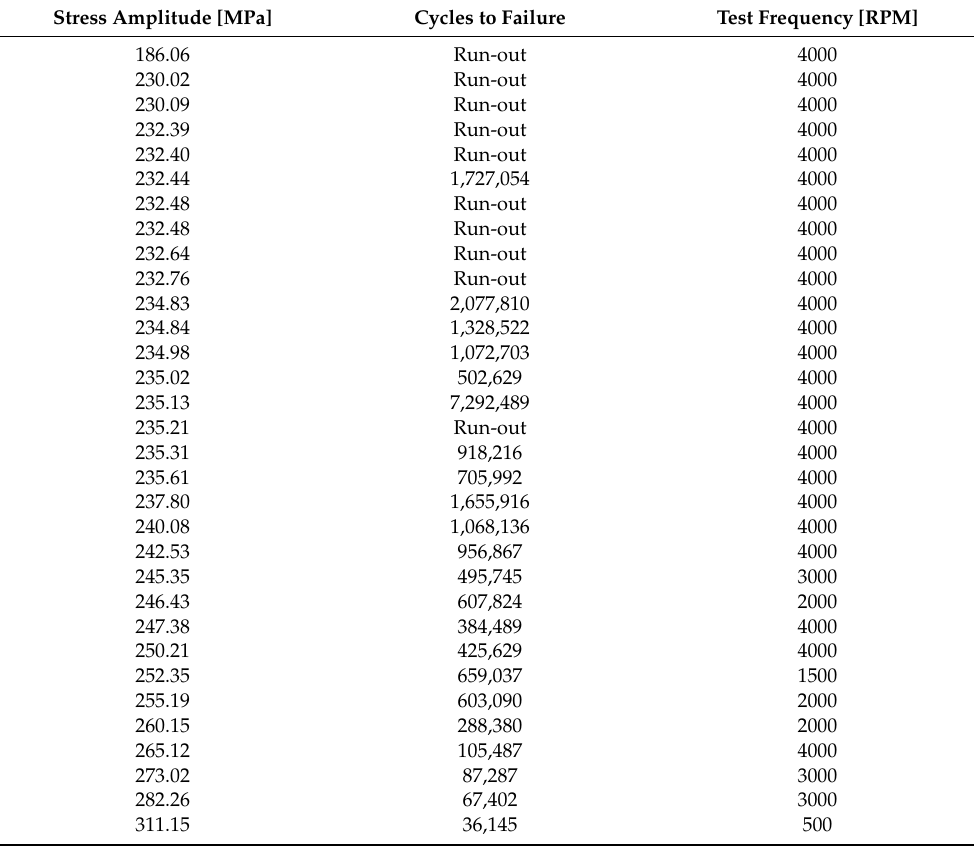
Table A1. Experimental results constant amplitude loading, specimens extracted from the trans- verse